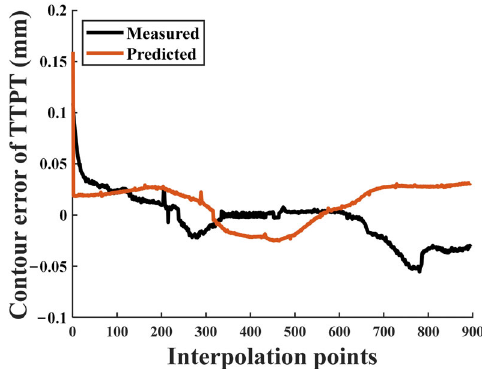
Figure 21. Predicted and measured contour errors of TTPT.